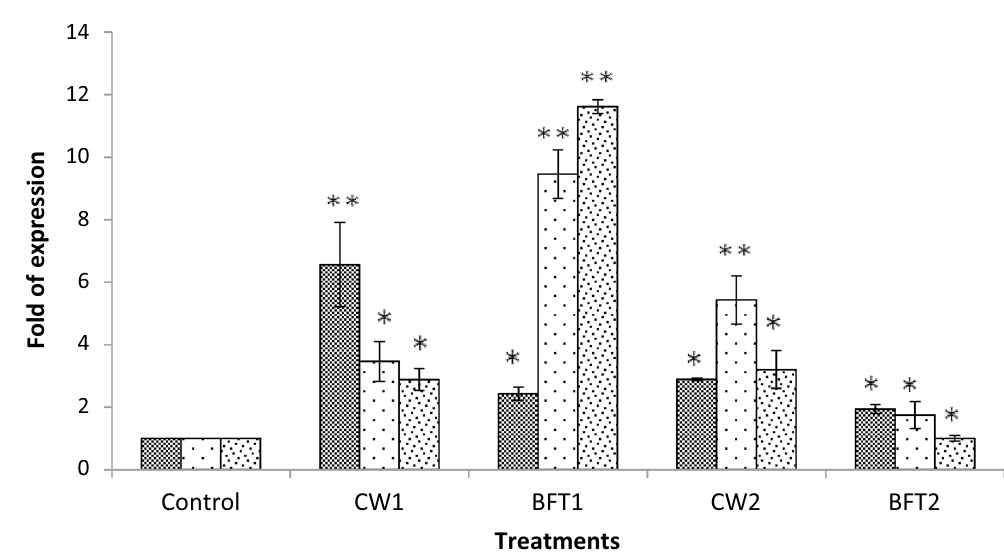
Figure 7. Expression level of cathepsin L, cathepsin B and alpha amylase of P. indicus reared in different treatments and error bar showing standard deviation of three replicates. Significance between different groups ( P < 0.05) marked with